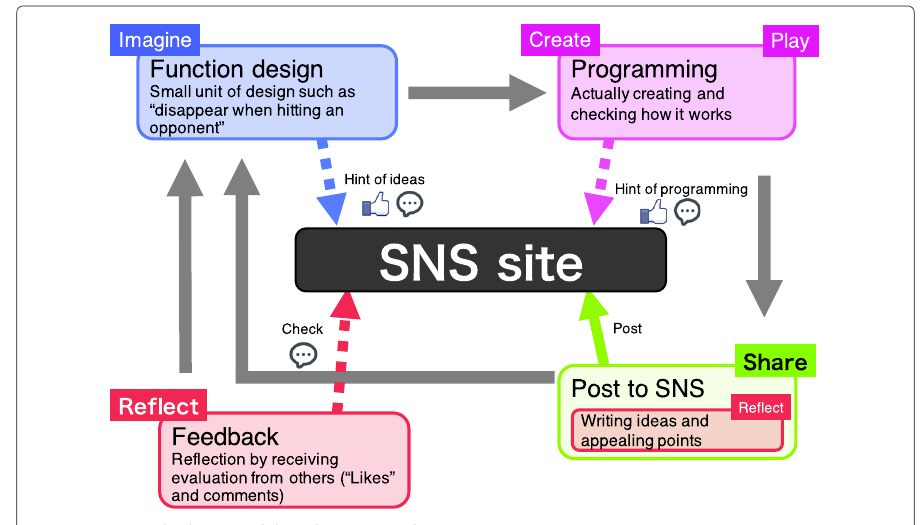
Fig. 8 Creative thinking model on the proposed